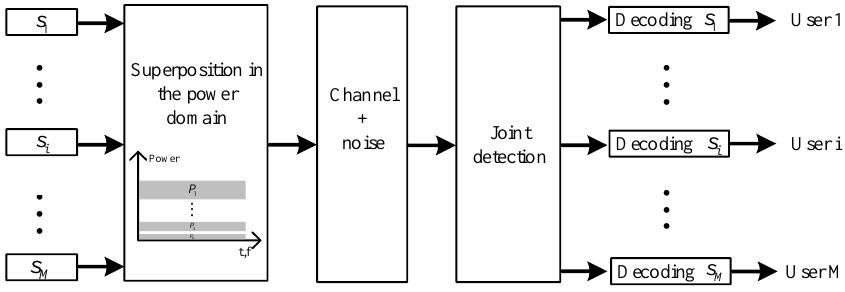
Figure 3. Illustration of our proposed NOMA